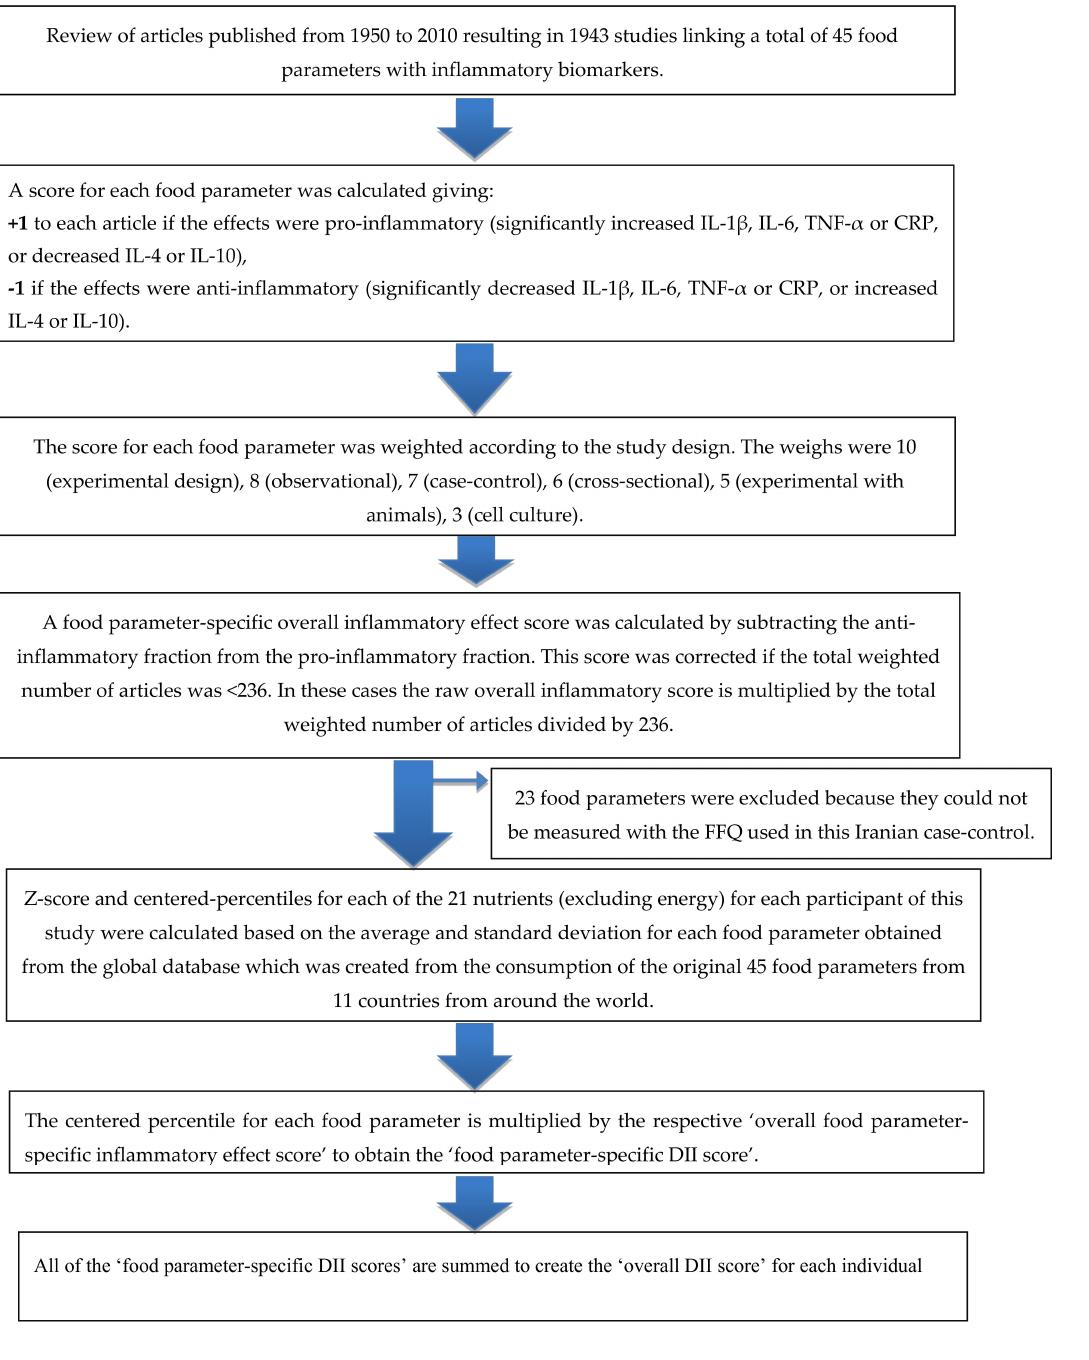
Figure 1. Sequence of steps in creating the energy-adjusted dietary inflammatory index (E-DII) scores in the Iranian colorectal cancer case-control